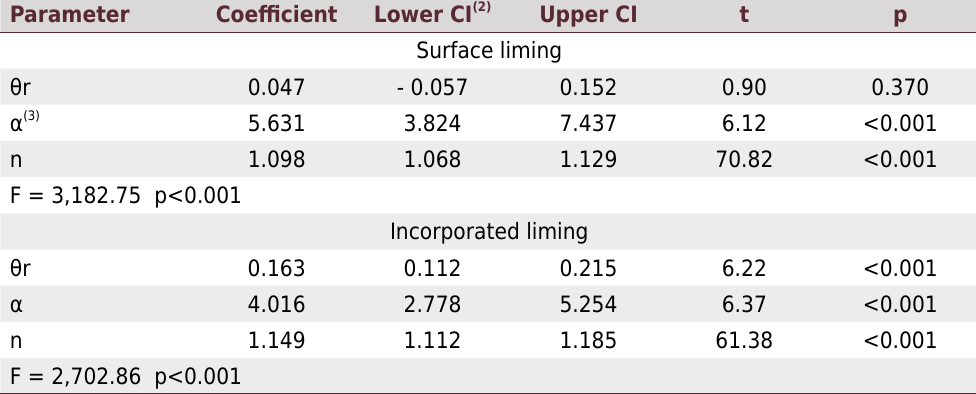
Table 1. Estimators of the parameters of equations of soil water content (θ) (1)